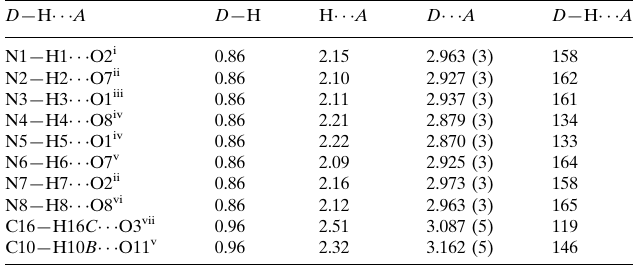
Hydrogen-bond geometry (A˚ , (cid:4)